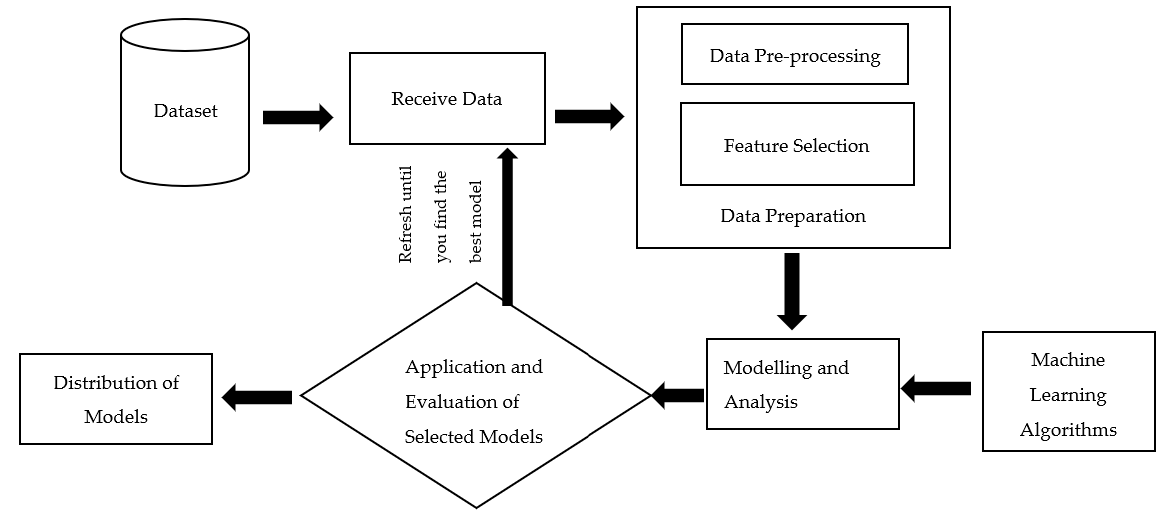
Figure 2. Workflow diagram of the study.